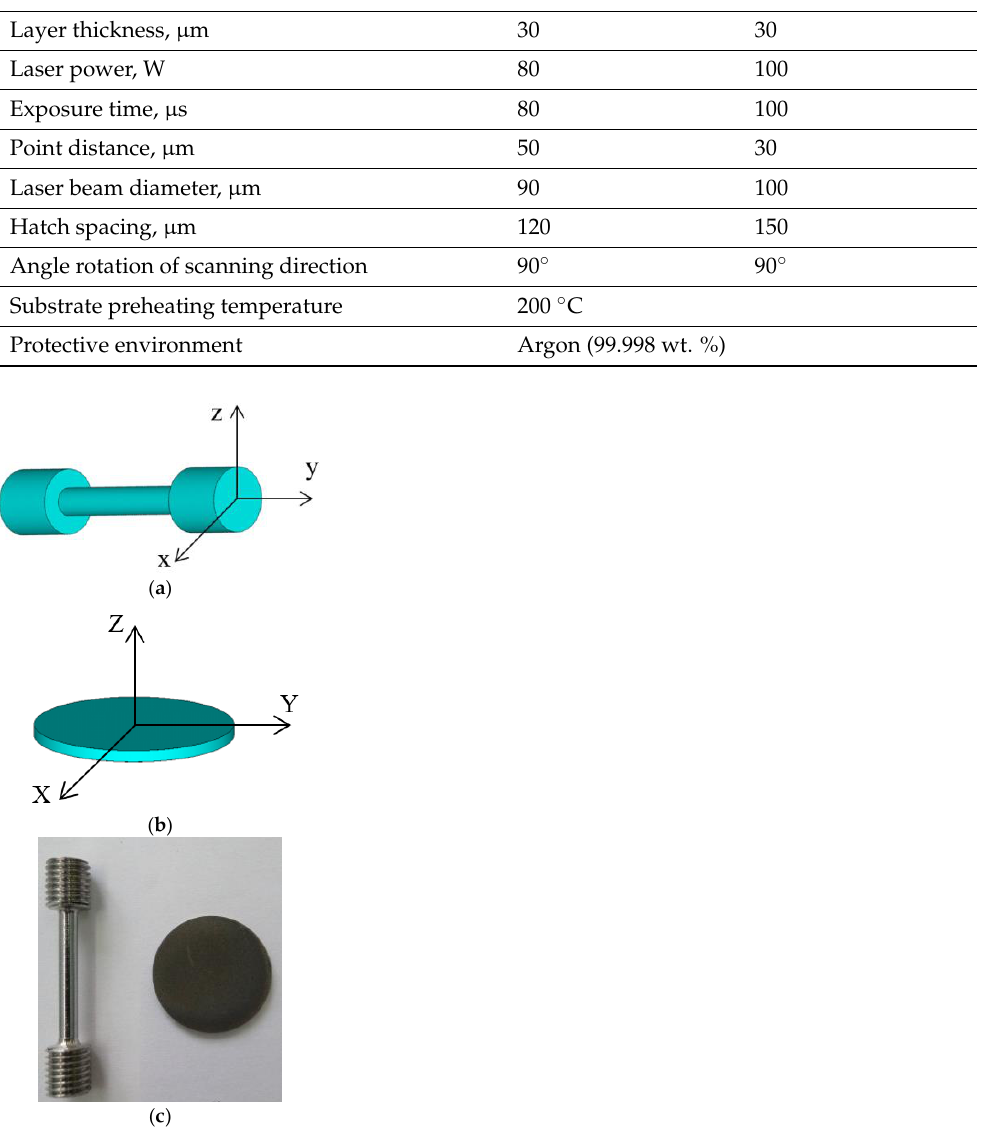
Table 2. Basic parameters of selective laser melting.